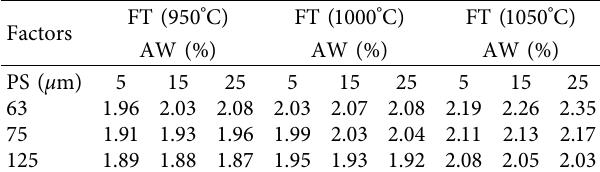
Table 1: Average values of